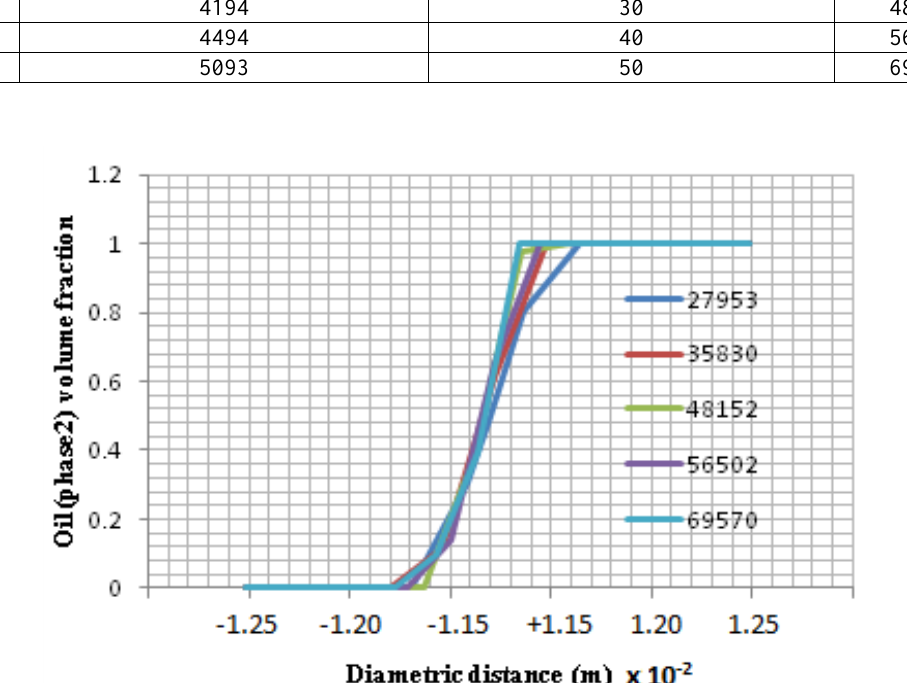
Figure 3. Diametric variation of oil volume fraction for different mesh size